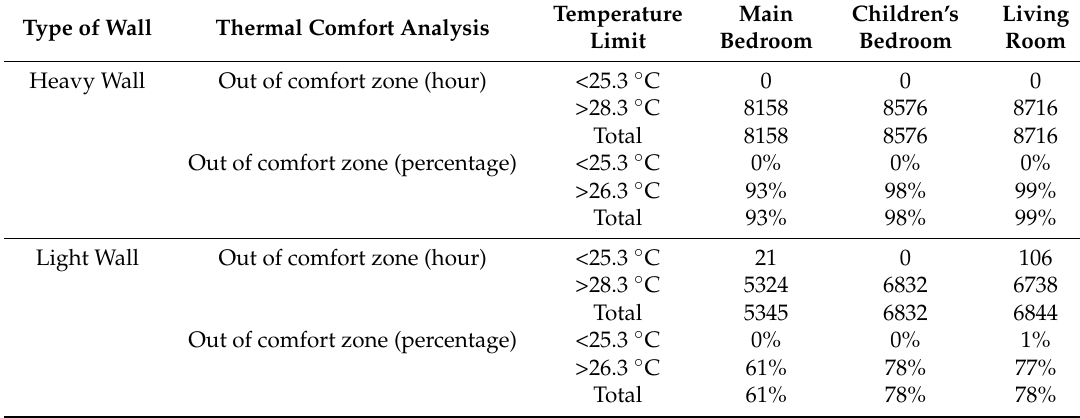
Table 20. Number of discomfort hours in house with alternate walls within a year.